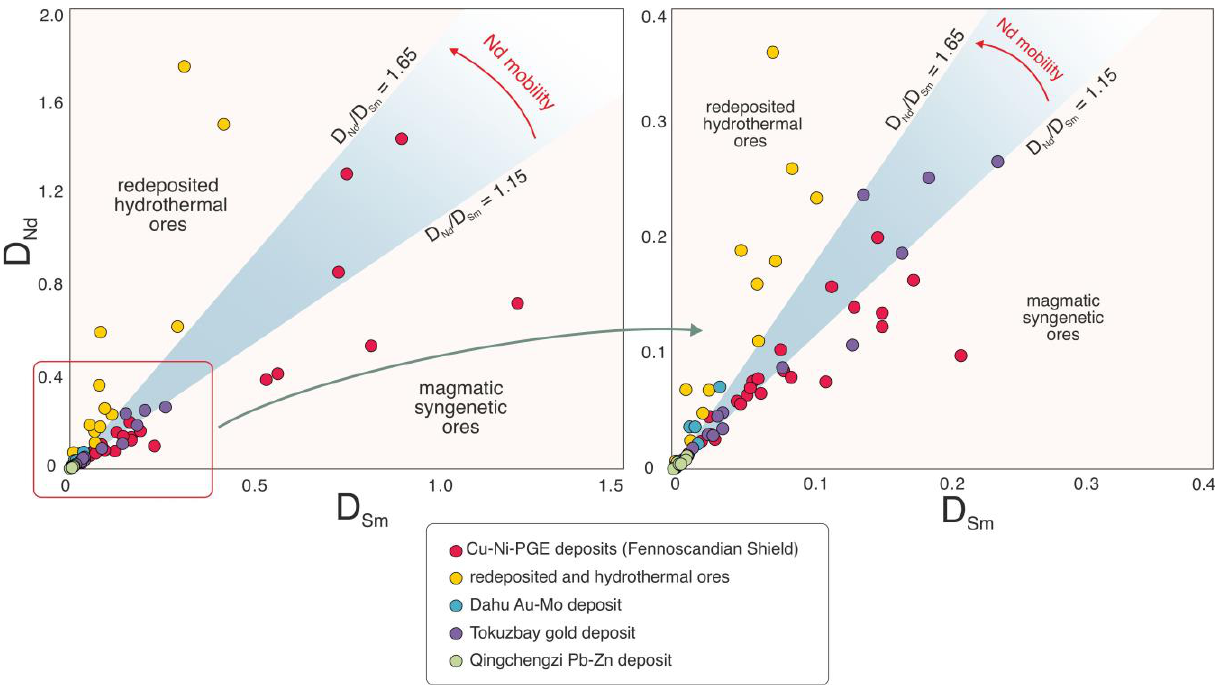
Figure 3. Partition coefficients D Nd – D Sm in sulfide minerals from the Cu-Ni-PGE deposits of the Fennoscandian Shield and hydrothermal Qingchengzi Pb-Zn (northeastern China) deposit [18], Tokuzbay gold deposit [6] (south Altai, northwest China), and Dahu Au-Mo deposit [7].